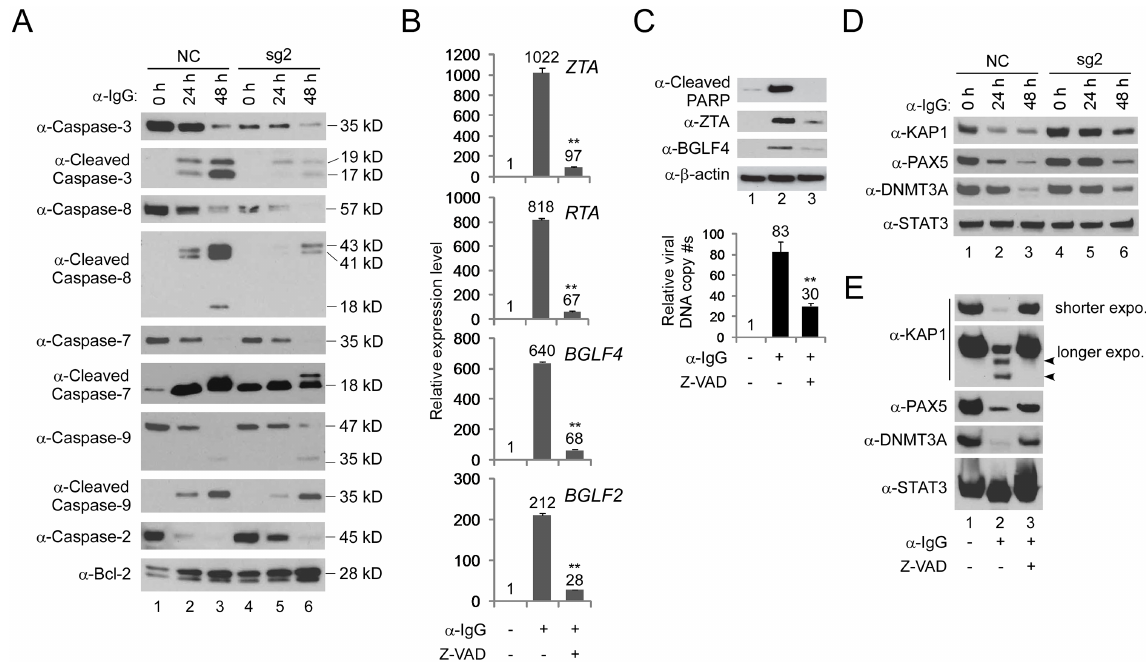
Fig 3. IRF8 depletion suppresses caspase activation and caspase activation is required for EBV lytic replication. A. IRF8 depletion suppresses caspase activation. Western blot analysis of protein extracts from Fig 1D using antibodies against caspase-3, cleaved caspase-3, caspase-8, cleaved caspase-8, caspase-7, cleaved caspase-7, caspase-9, cleaved caspass-9, caspase-2 and Bcl-2 as indicated. B. Caspase inhibition suppresses EBV lytic gene expression. Akata (EBV + ) cells were untreated or pre-treated with pan-caspase inhibitor (Z-VAD-FMK) for 1 hr and then anti-IgG was added for 48 hrs. RNA was extracted and EBV lytic gene expression was analyzed by RT-qPCR. Data are presented as means ± standard deviations of triplicate assays. (cid:3)(cid:3) p < 0.01 (compared with the second bar). C. Caspase inhibition suppresses EBV DNA replication. Protein extracts from cells treated as Panel B were analyzed by western blot using antibodies against cleaved-PARP, EBV ZTA and BGLF4 as indicated. β -actin was used as loading controls. Genomic DNA was extracted and relative EBV DNA copy numbers was measured by qPCR using primers specific to EBV BALF5 .The EBV copy number was normalized by qPCR using specific primers to β -actin . Data are presented as means ± standard deviations of triplicate assays. (cid:3)(cid:3) p < 0.01 (compared with the second bar). D. IRF8 depletion suppresses the degradation of KAP1, PAX5 and DNMT3A upon lytic induction. Western blot analysis of protein extracts from Fig 1D using antibodies against KAP1, PAX5, DNMT3A and STAT3 as indicated. E. Caspase inhibition restores the expression of KAP1, PAX5 and DNMT3A. Protein extracts from Panel C were analyzed by western blot using antibodies against KAP1, PAX5, DNMT3A and STAT3 as indicated. The longer exposure of KAP1 blot revealed two cleaved KAP1 products upon lytic induction (lane 2, arrow heads).